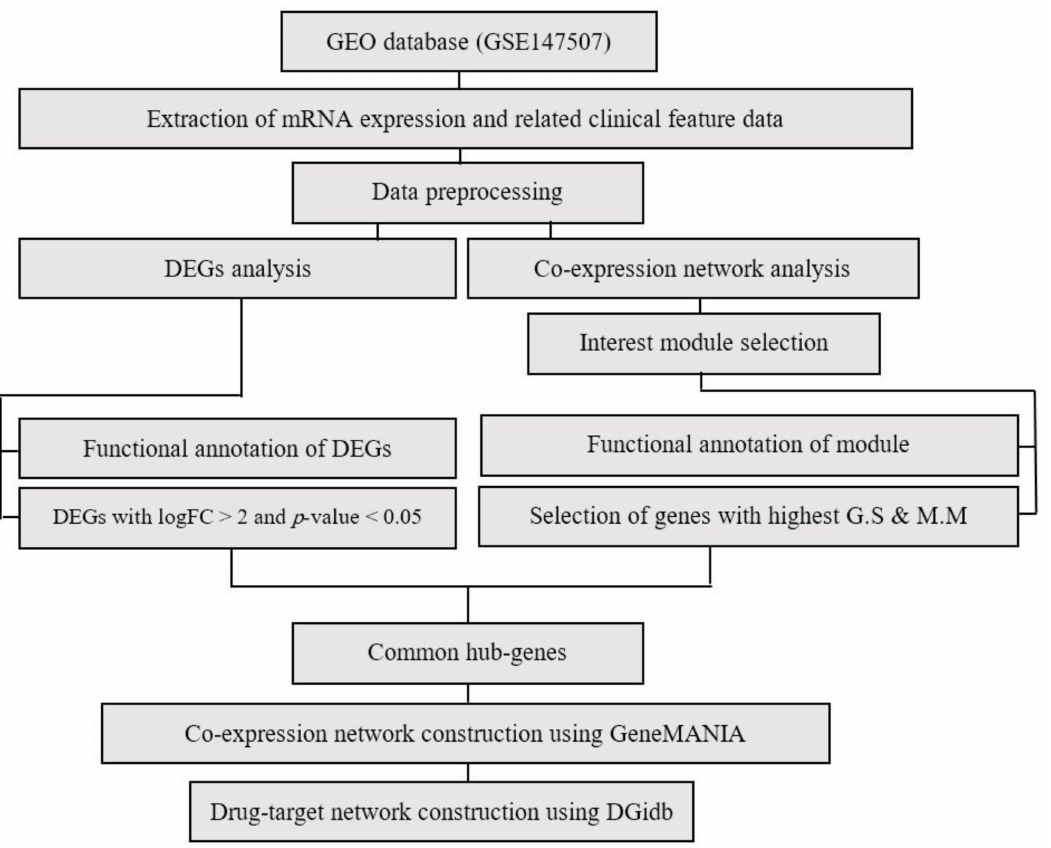
Figure 1. Flowchart of data preparation, processing, and analysis in this